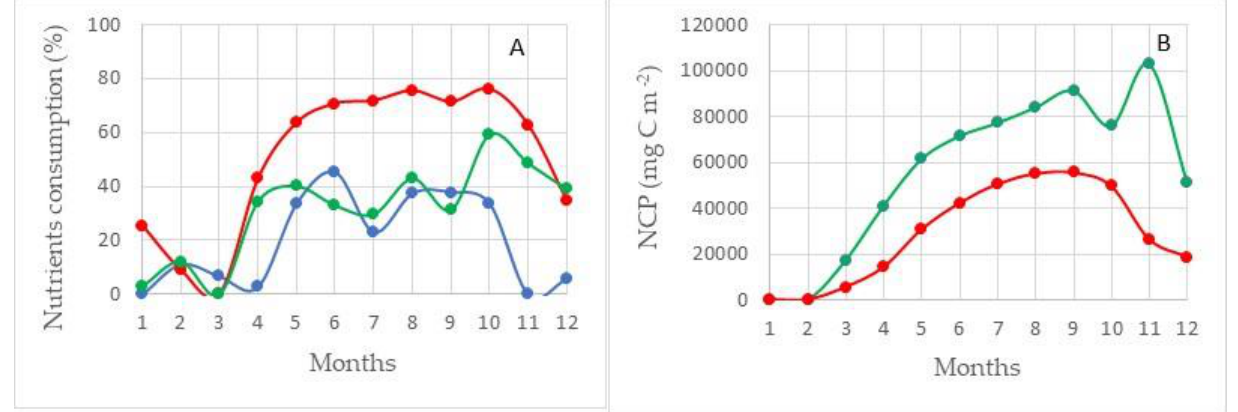
Figure 13. Annual cycle of primary production ( A ) and primary production ( B ) in Region IV; ( A ) is the consumed part of the nutrient supply in the process of photosynthesis (blue: mineral phosphorus, red; mineral nitrogen, green: silicon). ( B ) primary production (green: NCP Si ; red: NCP N ).